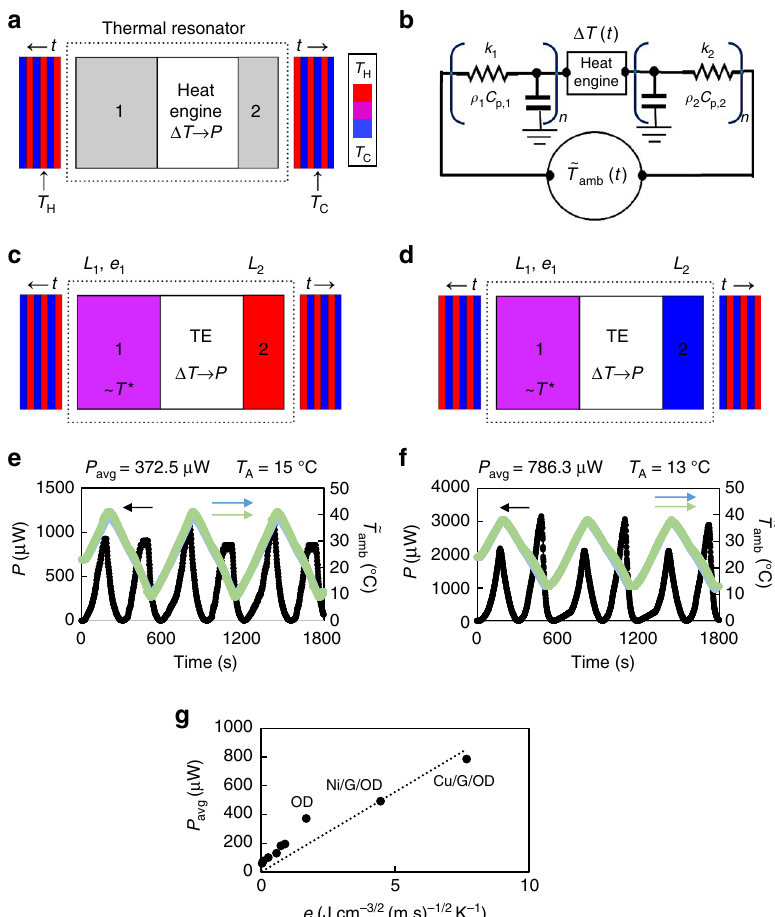
Fig. 3 Application of ultra-high thermal effusivity materials in a thermal resonator. a A general schematic of a thermal resonator. A heat engine is encased between two thermal masses (1 and 2), which convert input temperature fl uctuations — shown here as oscillating in time ( t ) between hot (red; T H = T 0 + T T = T − T — into a spatial temperature difference, Δ T ð t Þ , that is converted to power ( P ) by the heat engine. b A thermal A ) and cold (blue; C 0 A )